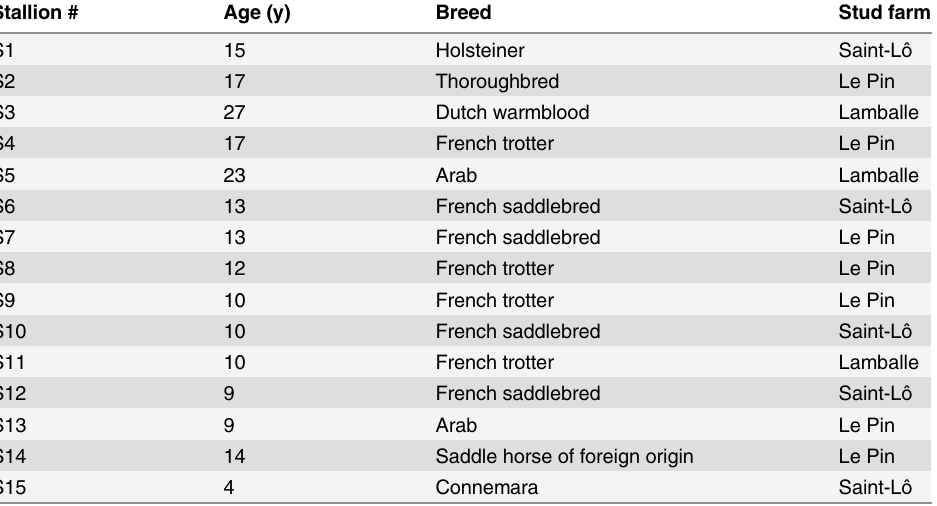
Table 1. Stallion ’ s characteristics. Stallion # Age (y)